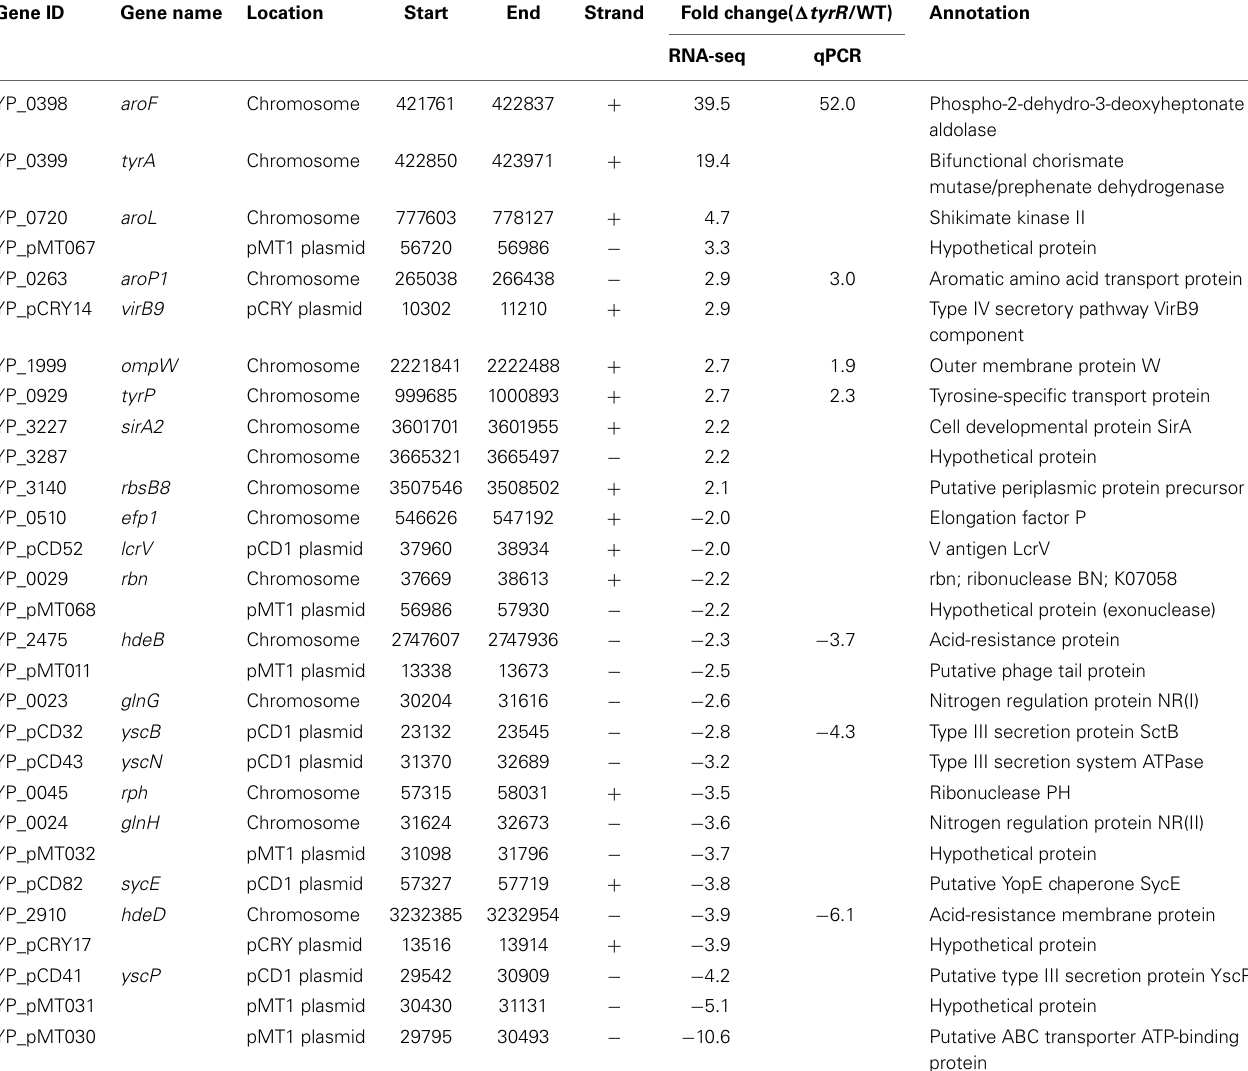
Table 1 | List of differentially regulated genes in tyrR mutant compared to WT strain. Gene